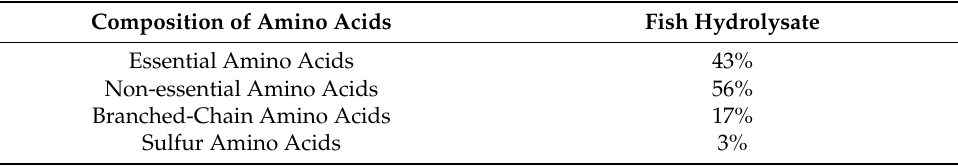
Table 2. Amino-acid composition of fish hydrolysate supplementation.